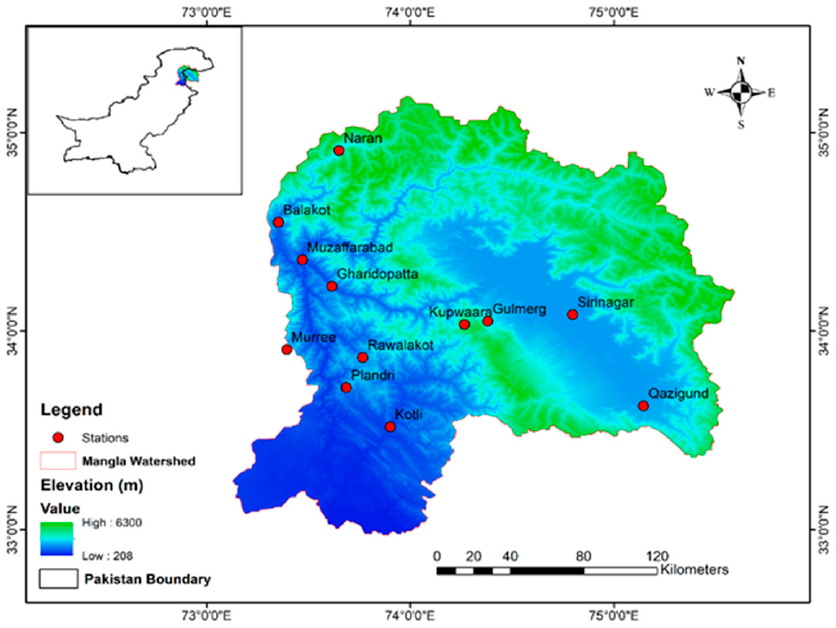
Figure 7. Mangla catchment study area.